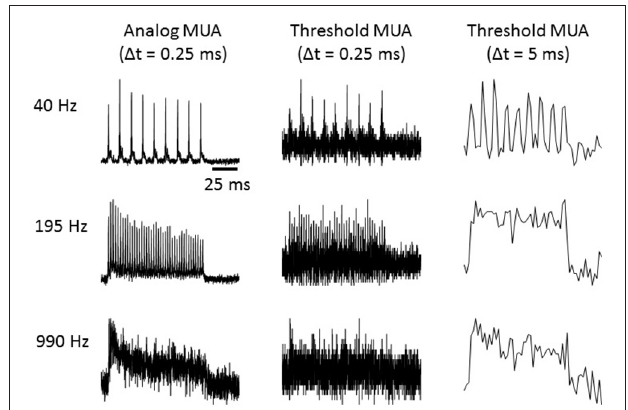
FIGURE 1 | Multi-unit responses quantified using either the “analog multi-unit activity (MUA)” method, or by counting threshold crossings with time bins as indicated. Responses to click trains presented at the click rates indicated to the left are shown. Each trace is the average response over 40